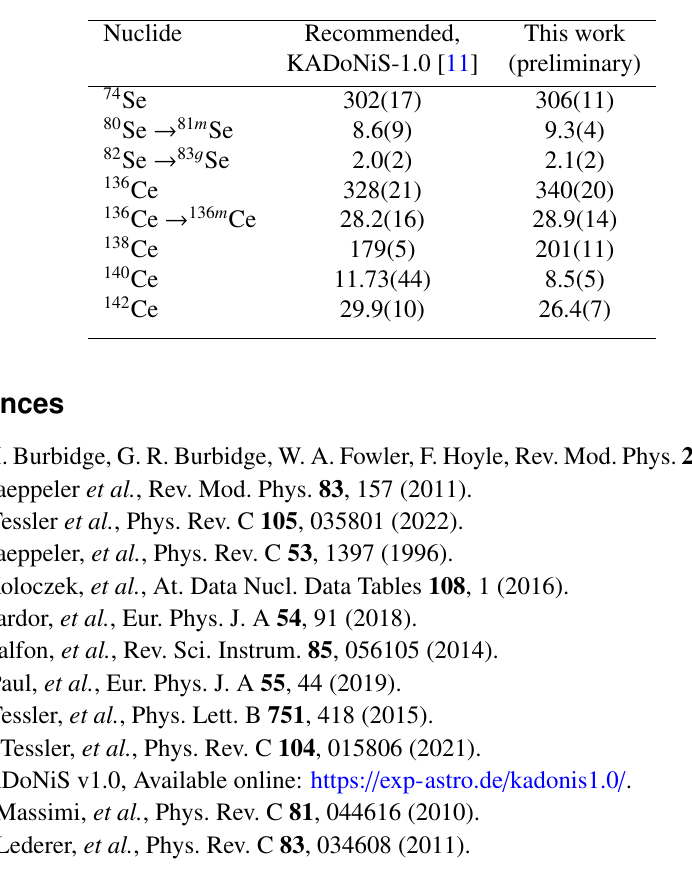
Table 1: Preliminary values (in mb) for MACS at 30 keV for the Se and Ce